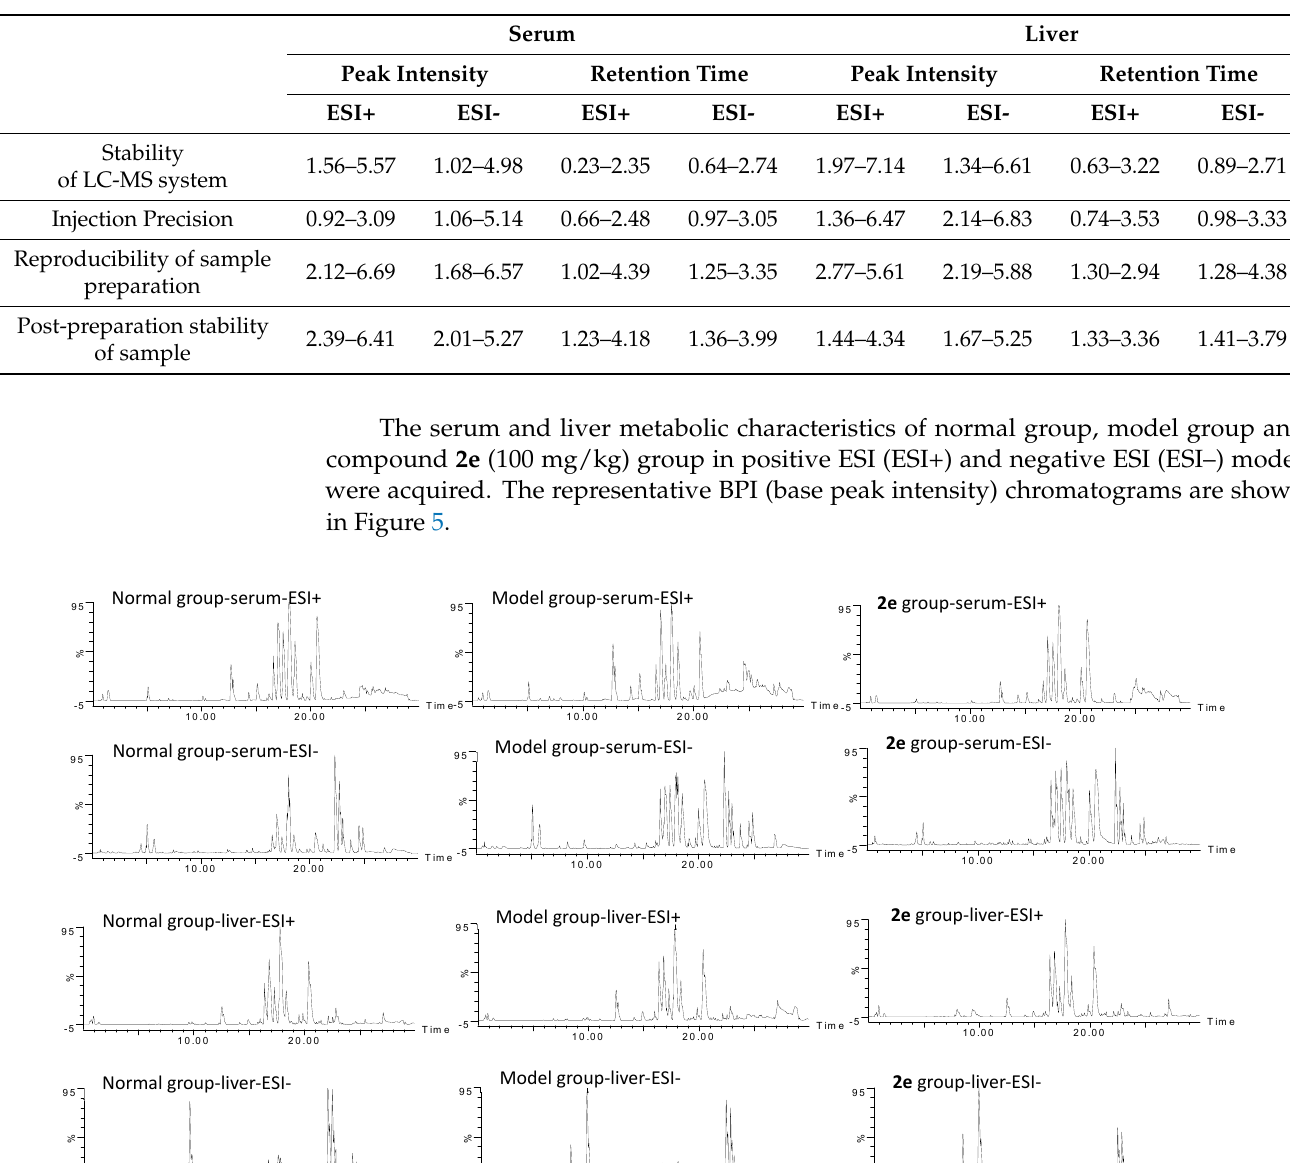
Table 5. The RSDs (%) of peak intensity and retention time in validation test.